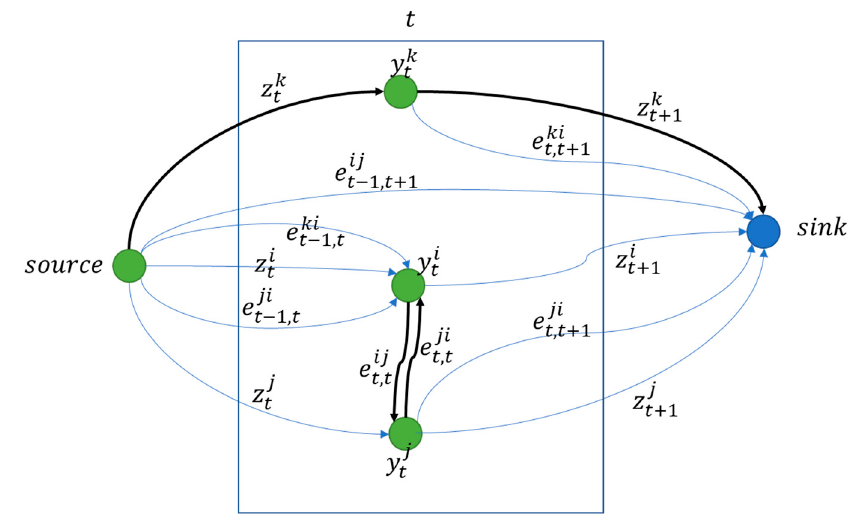
Figure 2. Illustration of the converted network (cid:101) G t ( V t , A t ) for bucket t . Variables corresponding to thick arcs have values of one and the others have values of zero. Circular setup change between ( i , j ) generates a subtour.